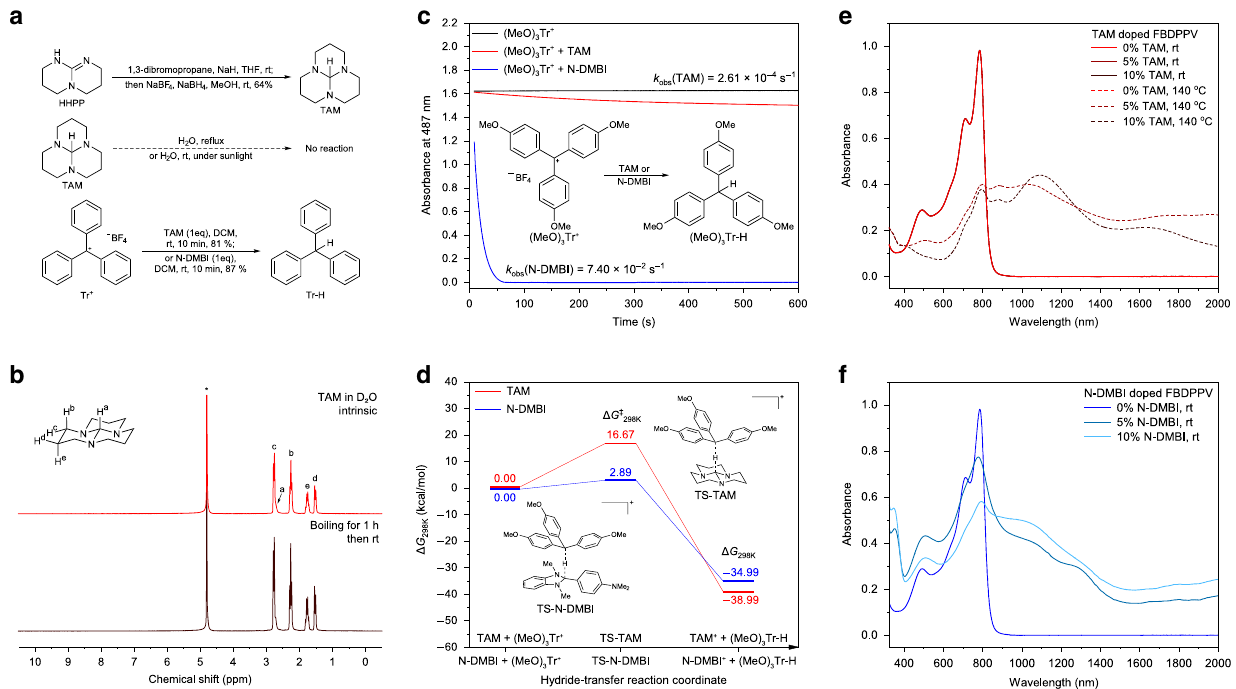
Fig. 3 Synthesis, chemical property, and n -doping kinetics. a Synthesis, chemical stability, and hydride-transfer ability of TAM. b Time-dependent 1 H- nuclear magnetic resonance ( 1 H-NMR) spectra of TAM in boiling H 2 O-d 2 . c Time-dependent absorbance of hydride-transfer reaction between (MeO) 3 Tr + and TAM (or N-DMBI). The initial concentrations are 2.38 × 10 − 5 M for (MeO) 3 Tr + , 1.42 × 10 − 4 M for both TAM and N-DMBI in anhydrous dichloromethane. d Density functional theory (DFT) calculated activation Δ G ‡ 298K , reaction Δ G 298K , and energy surface for hydride-transfer reaction between (MeO) 3 Tr + and TAM (or N-DMBI). DFT calculation performed under ω B97XD/6-311 + G(d,p)//B3LYP/6-31 G(d) level. e , f Absorption spectra of intrinsic and TAM ( e )- or N-DMBI ( f )-doped FBDPPV dilute 1,2-dichlorobenzene solution. The polymer concentration keeps 20 mg/L (in 1,2- dichlorobenzene) for each case, with different mass fraction of dopants after mixing for 5 min. TAM has ultra-high stability with strong n -doping ability at high lower reaction energy change ( Δ G 298K ) compared with N-DMBI